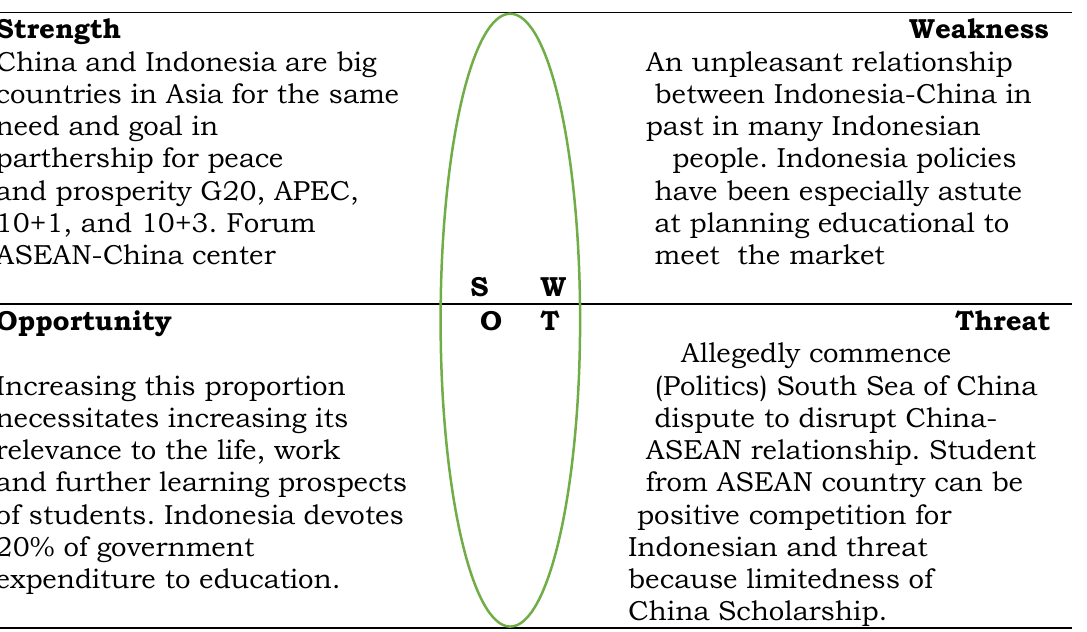
Table 7. SWOT Analysis Relationship Between ASEAN and